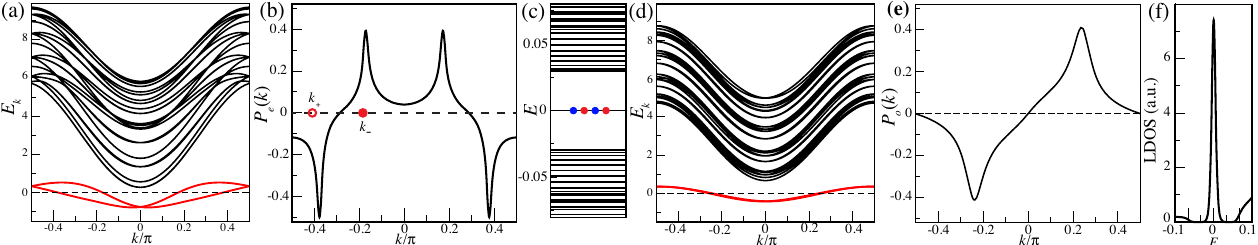
FIG. 4. (a) – (c) Even-parity-dominated quasi-1D TSC. (a) Normal state band dispersion plotted in the (1,1) direction in the 2D system ffiffiffi p 2 and very large L D ¼ L so that k is continuous. The red lines correspond to the incipient impurity bands and the with L ¼ 10 ð 1 ; − 1 Þ ð 1 ; 1 Þ black lines to the bulk bands. (b) The expectation value of the induced even-parity pairing order parameter P e ð k Þ in the RALD. The split Fermi points in (a) are marked as k and k − in (b) and enclose within the node of the pairing order parameter P e ð k (cid:4) Þ ¼ 0 . (c) Energy ffiffiffi þ p 2 spectrum obtained in a finite-size system with L D ¼ 250 , hosting four zero-energy MZMs denoted by blue and red dots. The parameters are μ 0 ¼ − 5 . 7 , μ d ¼ − 0 . 6 , t 1 ¼ − 0 . 4 , t 0 2 ¼ 0 . 01 , Δ 1 ¼ Δ 2 ¼ 0 . 1 , Δ 0 2 ¼ 0 , α 1 ¼ 0 , and α 2 ¼ 0 . 2 . (d) – (f) Odd-parity- dominated quasi-1D TSC. (d) Normal state band dispersion plotted in the (1,1) direction with the nearly spin-degenerate incipient impurity band in red. (e) The expectation value of the induced odd-parity pairing order parameter P o ð k Þ in the RALD. (f) LDOS ffiffiffi p 2 spectrum at each end of the RALD in a finite-size system with L D ¼ 250 , showing the zero-energy peak due to the MZMs. The parameters are μ 0 ¼ − 4 . 7 , μ d ¼ − 0 . 7 , t 1 ¼ 0 , t 0 2 ¼ 0 . 1 , Δ 1 ¼ 0 . 1 , Δ 2 ¼ Δ 0 2 ¼ 0 , α 1 ¼ 0 . 5 , and α 2 ¼ 0